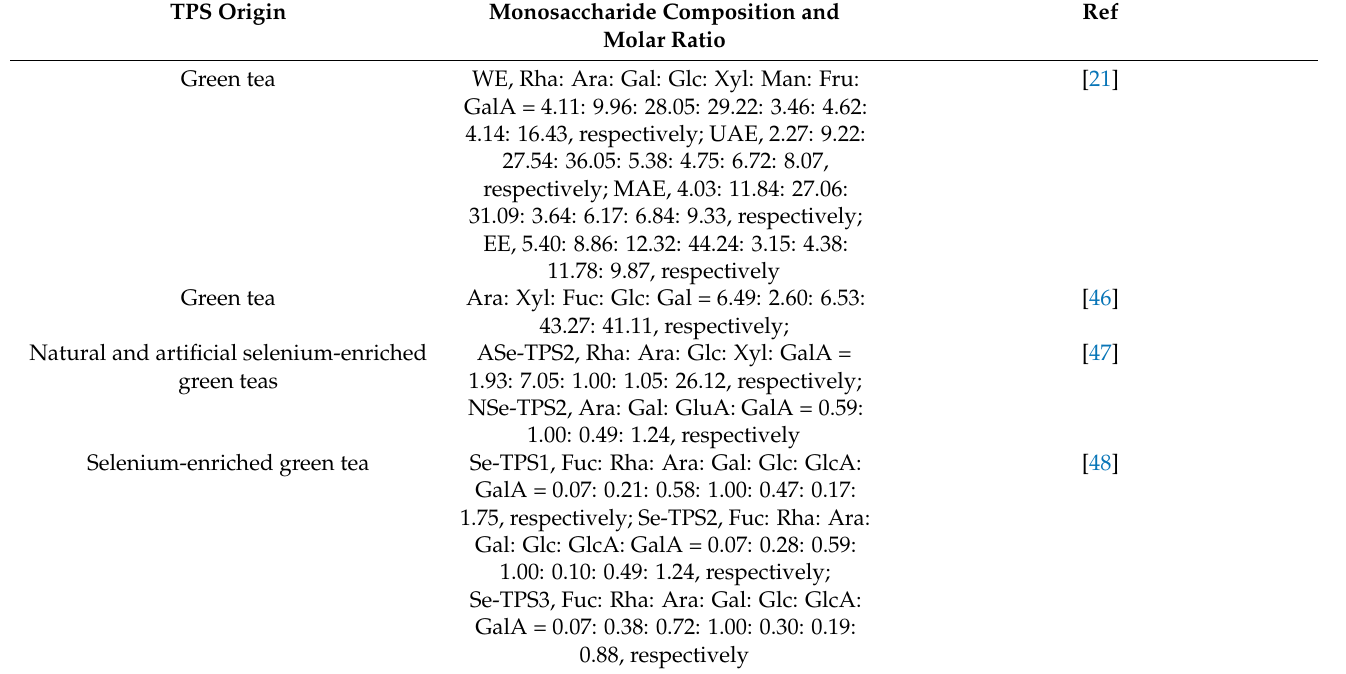
Table 2. Monosaccharide composition of different